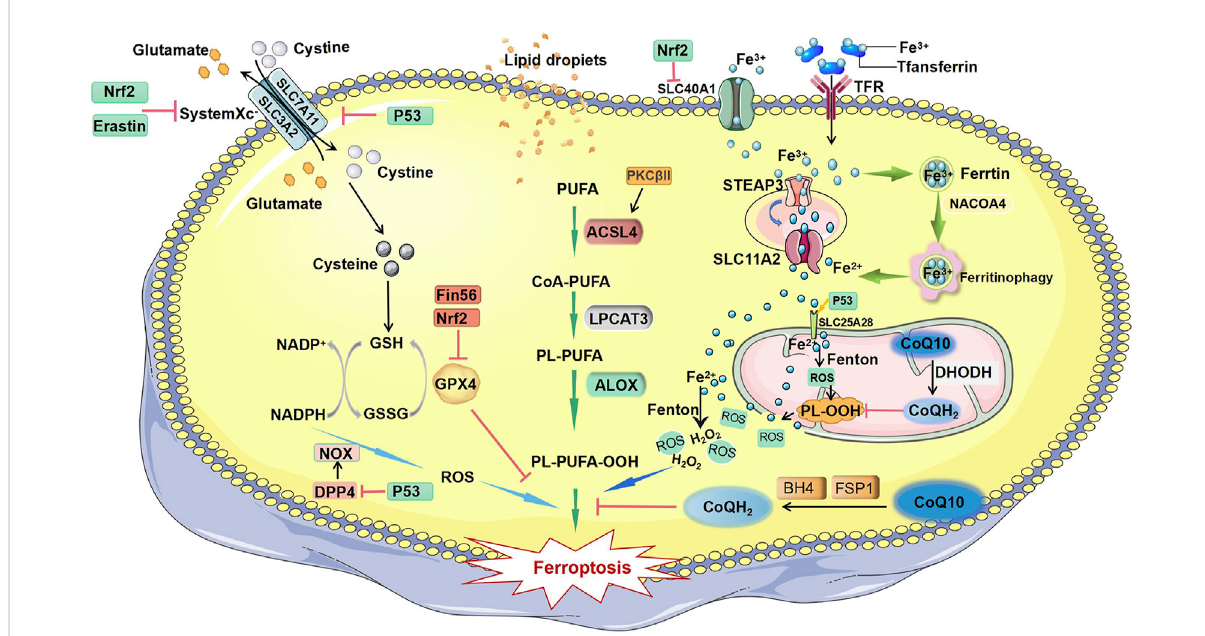
FIGURE 1 Mechanisms of ferroptosis. The initiation of ferroptosis requires two key signals, lipid peroxidation and accumulation of free iron. The generation of polyunsaturated phospholipids (by ACSL4 and LPCAT3) or PUFA-ePLs (by peroxisomal enzymes) and subsequent activation of ALOX have a major role in promoting lipid peroxidation, which can be inhibited by GPX4 and PKC β II. Extracellular iron enters the cell through TFR and facilitates the Fenton reaction to promote PUFA-PL oxidation. Some free iron stored in ferritin is released by ferritinophagy-mediated ferritin degradation. Iron can promote FSP1-CoQ10-NADPH pathways, and BH4 can block the propagation of phospholipid peroxidation and ferroptosis. Abbreviations: ALOX, lipoxygenase; ACSL4, acyl-CoA synthetase long chain family member 4; BH4, tetrahydrobiopterin; CoA-PUFA, coenzyme A-polyunsaturated fatty acid; CoQ10, coenzyme Q10; CoQH2, ubiquinol; DPP4, dipeptidyl peptidase 4; DHODH, dihydroorotate dehydrogenase; Fin56, ferroptosis inducer 56; FSP1, ferroptosis suppressor protein 1; GPX4, glutathioneperoxidase 4;GSH, glutathione;GSSG, oxidized glutathione; H 2 O 2 , hydrogen peroxide; LPCAT3, lysophosphatidylcholine acyltransferase 3; Nrf2, nuclear factor erythroid 2-related factor 2; NADPH, nicotinamide adenine dinucleotide phosphate; NADP+, nicotinamide adenine dinucleotide phosphate; NACOA4, nuclear receptor coactivator 4; NOX, NADPH oxidase; PKC β II, protein kinase C beta type isoform; PUFA, polyunsaturated fatty acid; PL-PUFA, phospholipid-containing polyunsaturated fatty acid; PL-PUFA-OOH, phospholipid with a peroxidized polyunsaturated fatty acyl tail; P53, protein 53; PL-OOH, phospholipid hydroperoxide; ROS, reactive oxygen species; Slc7A11, solute carrier family 7 member 11; SLC11A2, solute carrier family 11 member 2; SLC25A28, solute carrier family 25 member 28; SLC40A1, solute carrier family 40 member 1; STEAP3, six transmembrane epithelial antigen of the prostate 3; TFR, transferrin